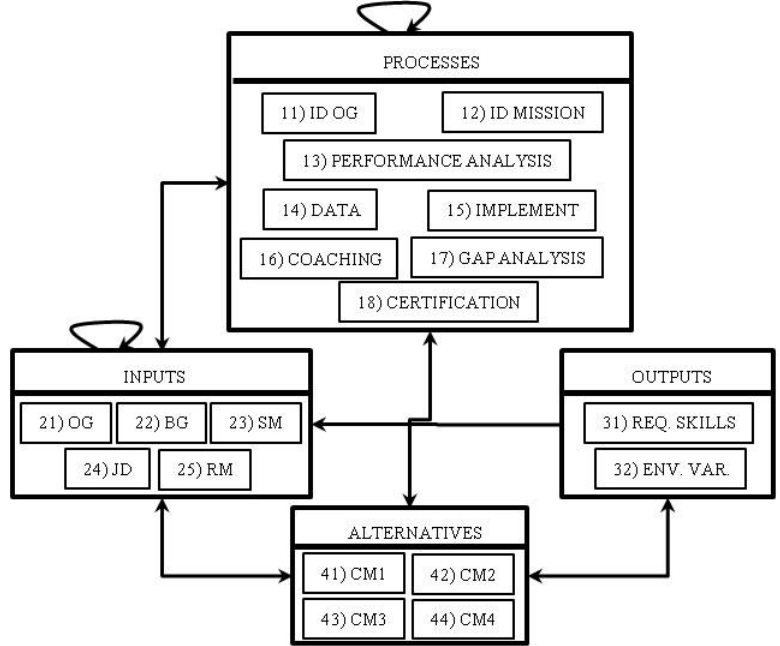
Fig. 3. The Framework of